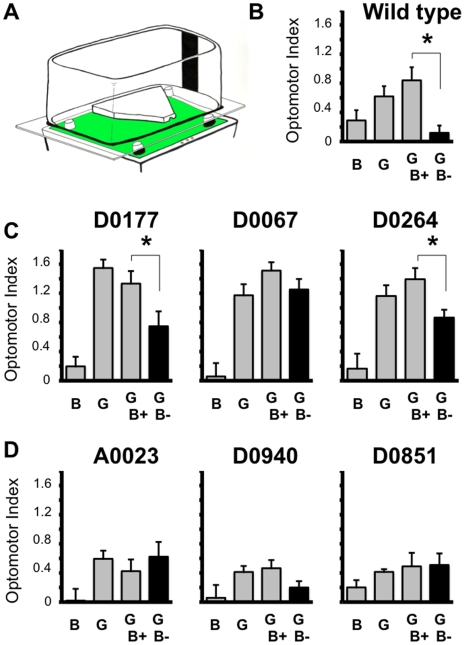
Distraction paradigm.A. Distractibility (see Methods) is demonstrated by significantly reduced (*, P<0.05) optomotor responsiveness in the presence of a competing static black bar on the side opposite of optomotor flow compared to the image being on the same side [1]. B. Data for wild-type flies. B, response (±s.e.m.) to the static bar alone; G, response to the moving grating alone; GB+, response when the bar is on the same side as the direction of the moving grating; GB-, response when the bar is on the side opposite to the direction of grating movement. The bar on the side opposite to grating movement (black histogram) significantly reduces the optomotor response. C. Distractibility profile for the three strongest optomotor performers, D0177, D0067, and D0264. D. Distractibility profile for three average optomotor performers, A0023, D0940, and D0851.